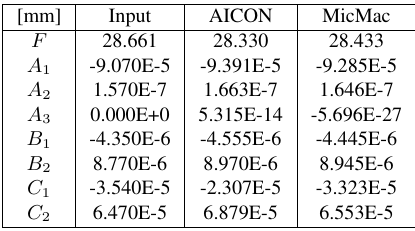
Table 3: Comparison of the “true” and estimated interior camera parameters for Scenario